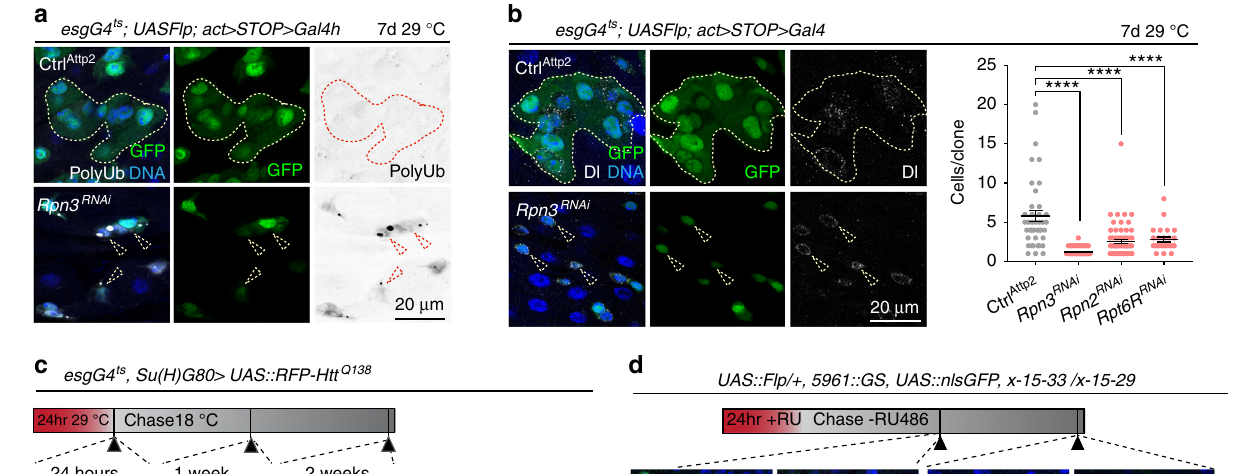
NATURE COMMUNICATIONS| (2019) 10:1050